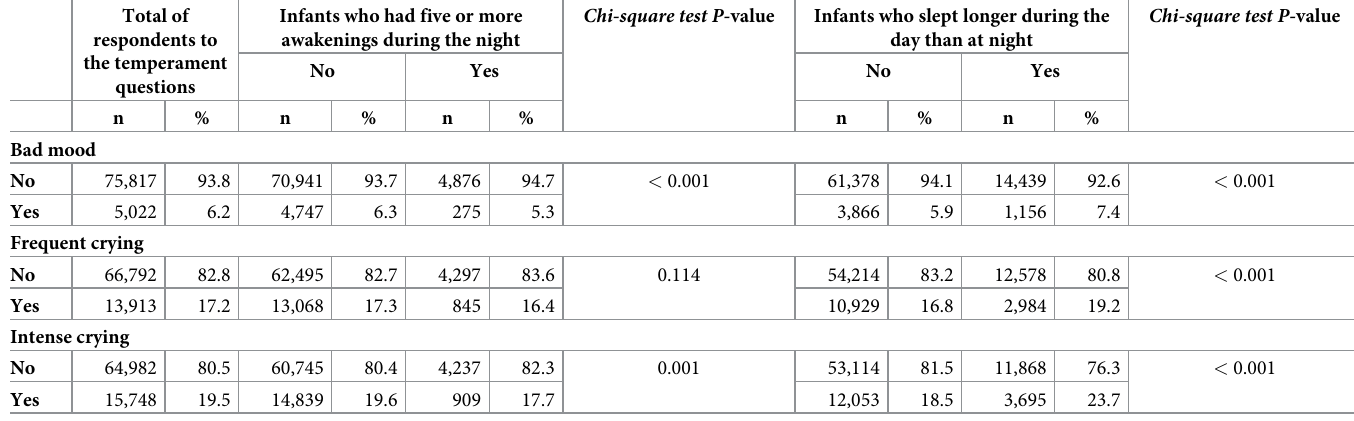
Table 2. Relationship between infant sleep quality and temperament in one-month-olds according to the Chi-square test. Total of respondents